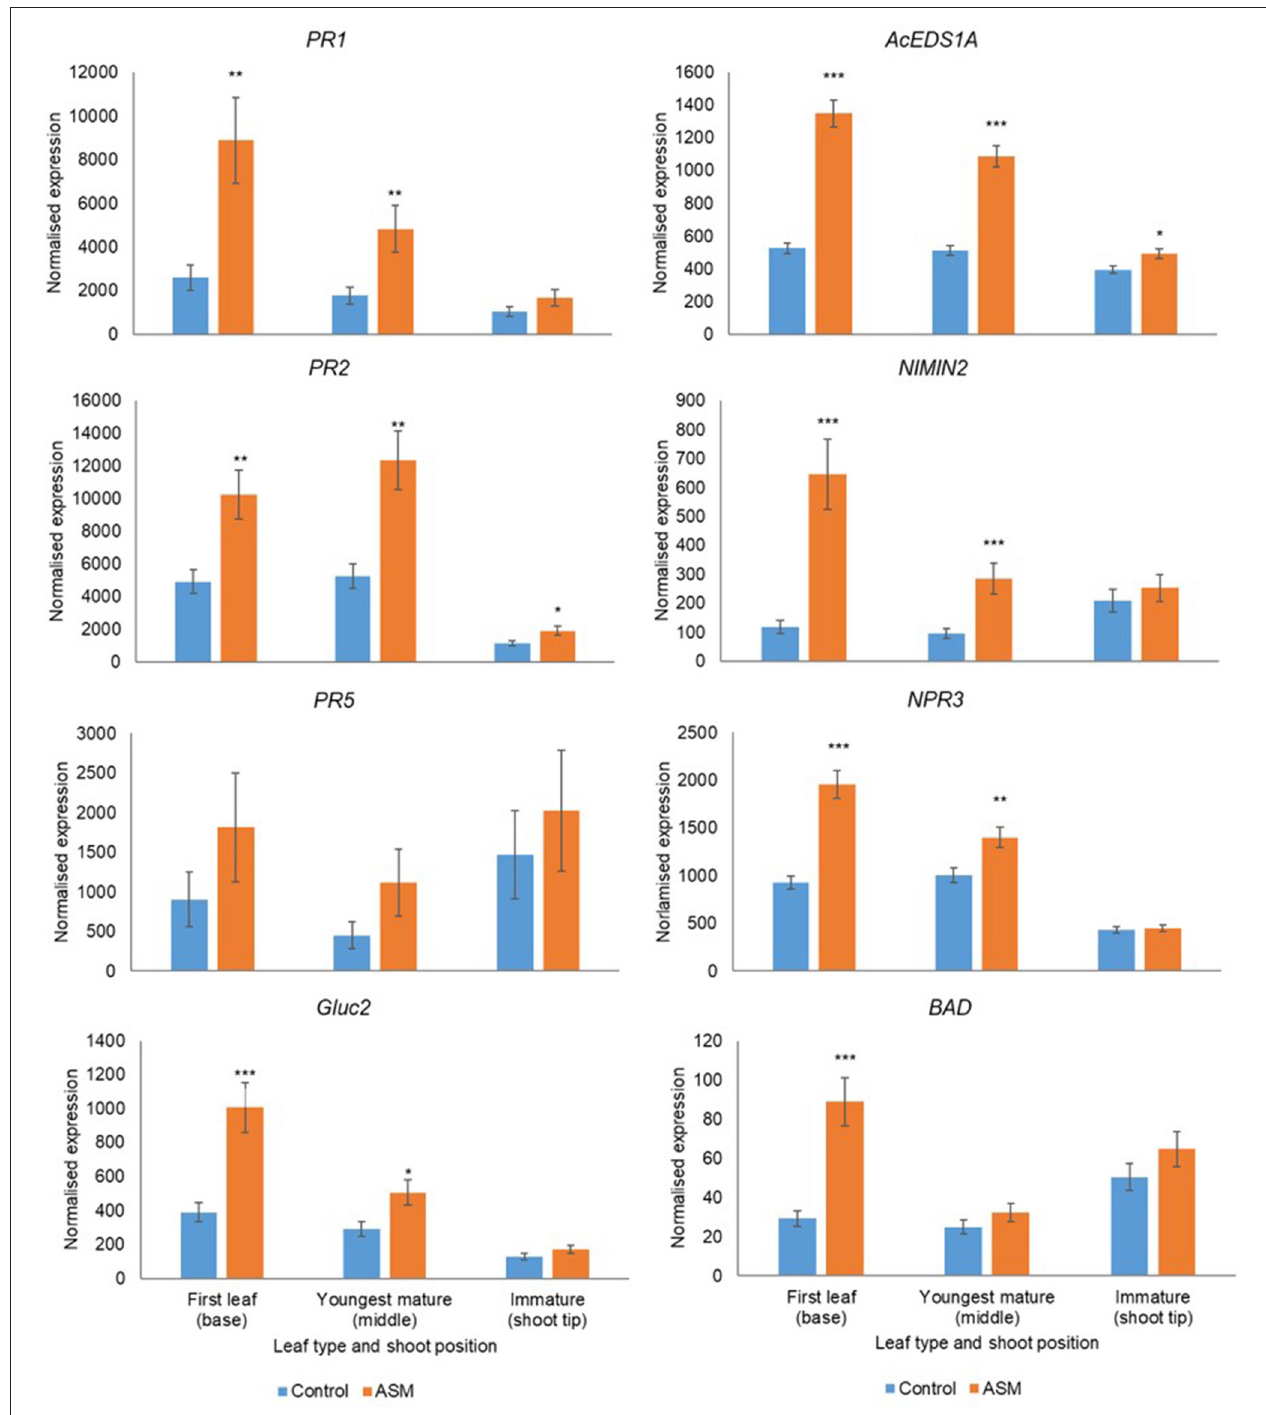
FIGURE 7 | Expression of PR1, PR2, PR5, AcEDS1A, NIMIN2 , NPR3, and BAD in Actinidia chinensis var chinensis ‘Zesy002’ leaves of differing maturity in spring 2018, as measured by PlexSet® NanoString, and the Y-axis represents physical counts of the number of molecules expressed. Actigard (ASM) was sprayed on 27 September, 10 October, and 24 October and leaves were sampled on 25 October. Data were normalised against six reference genes— 40s rRNA , actin , elongation factor , glyceraldehyde 3-phosphate dehydrogenase , protein phosphatase 2A , and ubiquitin-conjugating enzyme . Data were log 2 transformed for analysis, but are presented as back-transformed means. Asterisks above bars indicate significant treatment differences, where * < 0.05, ** < 0.01, and *** < 0.001.